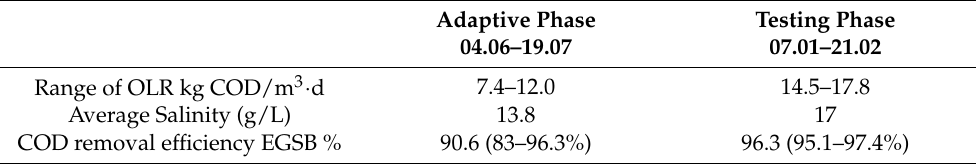
Table 5. COD removal during two test periods at given salinity